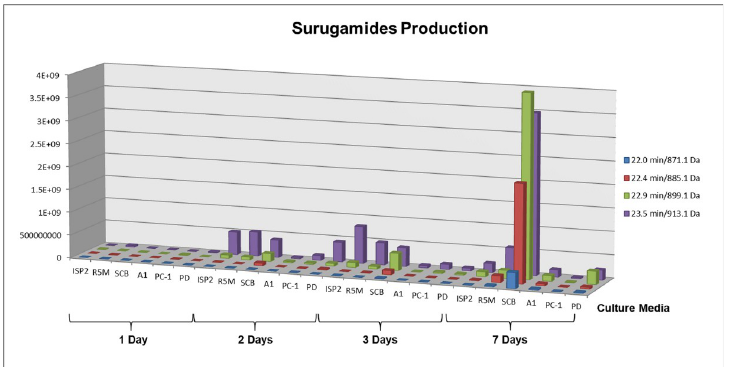
Fig 4. Surugamides production over 1, 2, 3 and 7 days of cultivation. Comparison of peak areas over time and culture